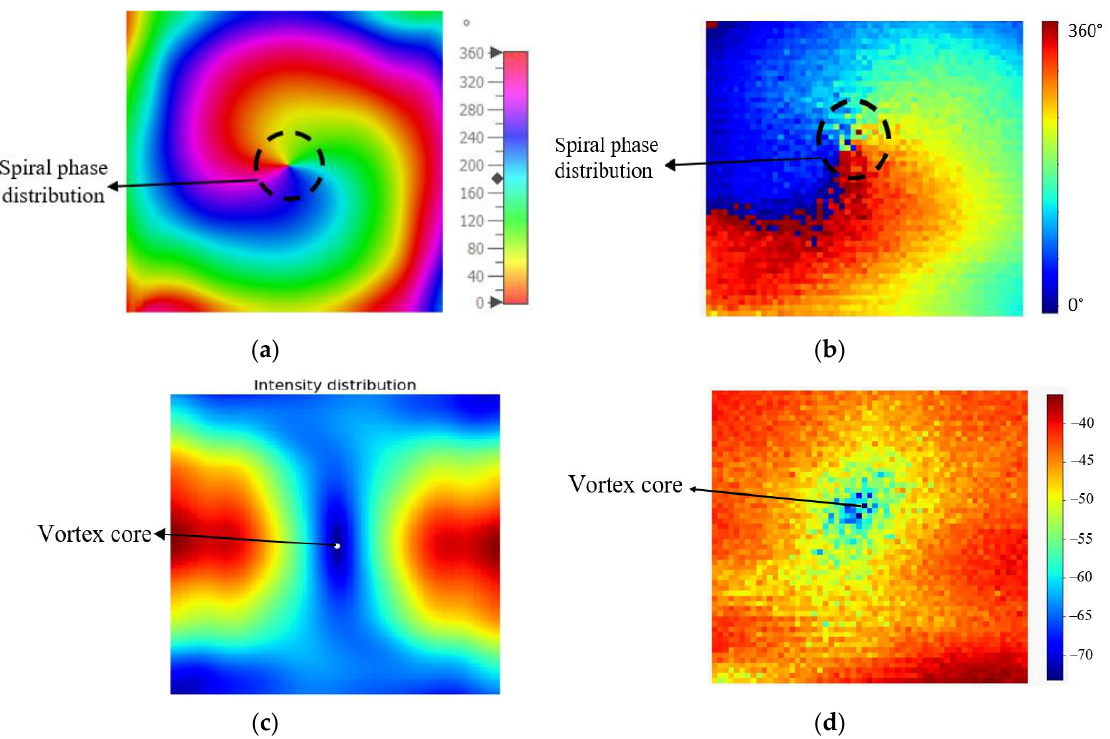
Figure 7. Radiation and intensity distributions at 3.56 GHz. ( a ) Simulated phase distribution; ( b ) measured phase distribution; ( c ) simulated intensity distribution; ( d ) measured intensity distribu- tion.